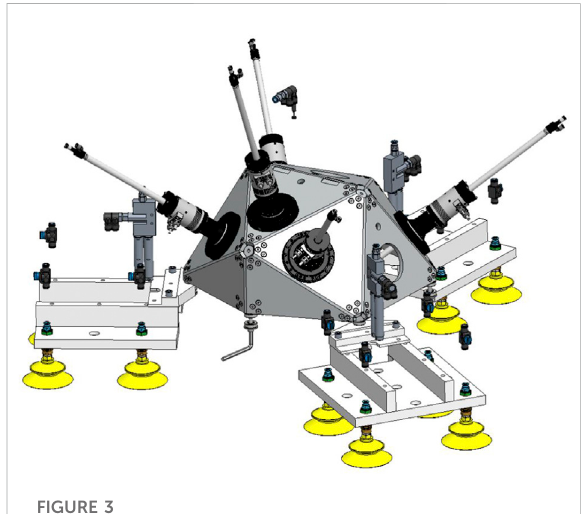
FIGURE 3 Mobile machine tool with parallel kinematic design equipped with a pneumatic coupling